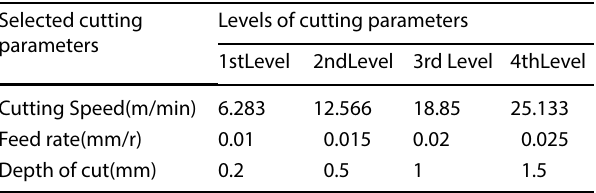
Table 1 Cutting Parameters levels for Cutting Force SiCp/Al45% and 50% [40] Selected cutting Levels of cutting parameters